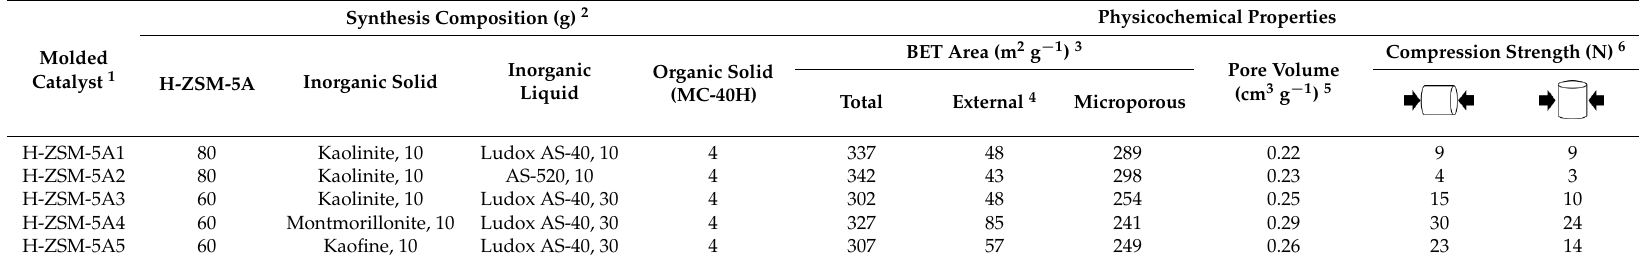
Table 2. Synthesis and characterization of molded catalyst.